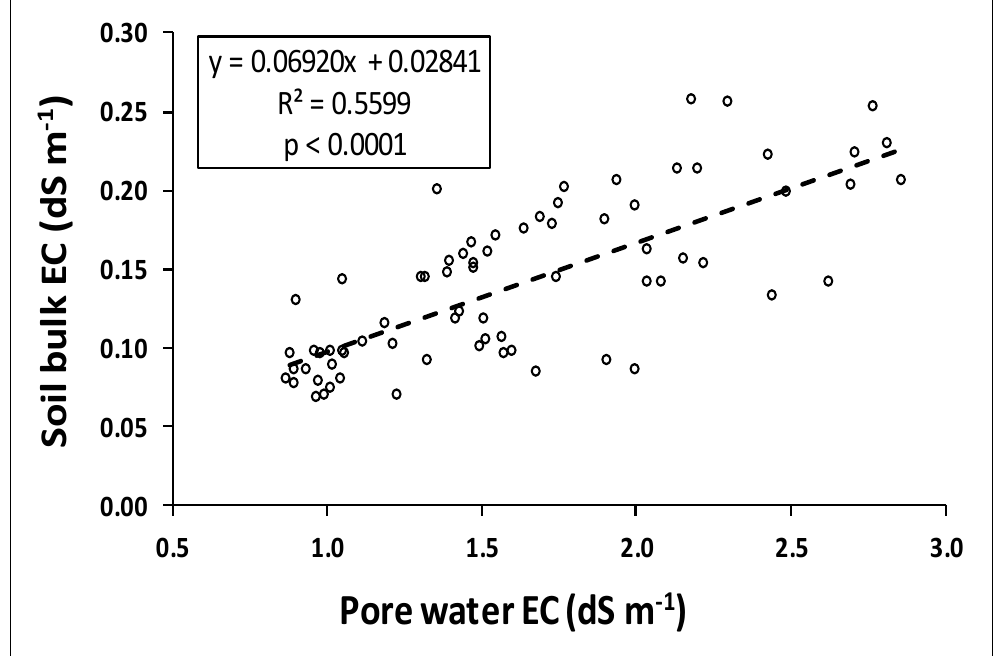
Figure 3. Linear regression analysis of soil bulk EC and pore water EC for all nine treatments. Treatments consist of inoculation type (IC = No inoculation, IT1 = Mycorrhizal, IT2 = Rhizobium + Mycorrhizal) and salinity levels (SC = Salinity control 0.6 dS m −1 EC, S1 = 1.0 dS m −1 EC, and S2 = 2.0 dS m −1 EC). Values are expressed as mean and each treatment consisted of n = 10. The dashed line represents a positive linear trend that’s significant at p < 0.05.